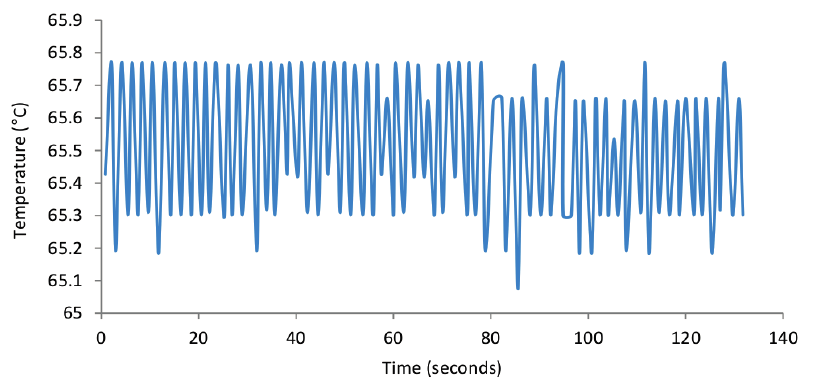
Figure 6. Isothermal plate heating and temperature stability characteristics. The device was heated from room temperature to operating temperature (65 °C) with continual temperature measurements to characterise the thermal properties over long time spans.